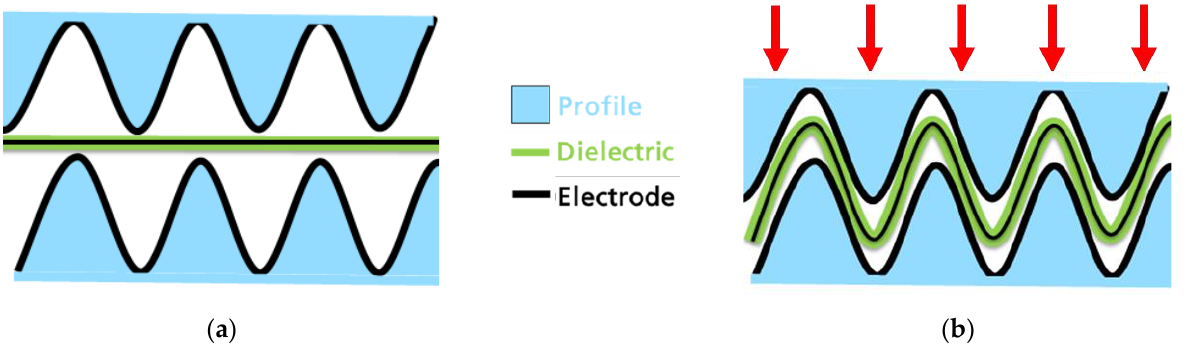
Figure 7. Scheme of a dielectric elastomer pressure sensor with two outer films with wave-shaped profiles and electrode layers on the profiles and an elastomer film with only one electrode layer covered by two dielectric layers between the profiles in the unloaded state ( a ) and in the loaded state ( b )